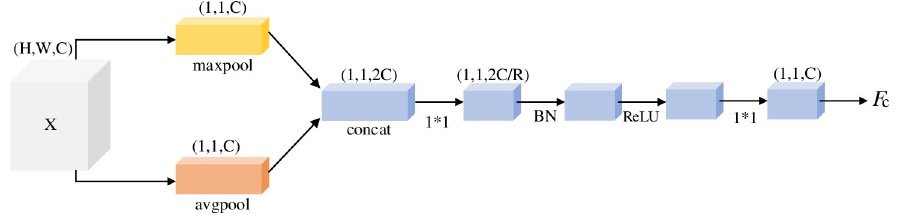
Fig 5. Channel attention module.